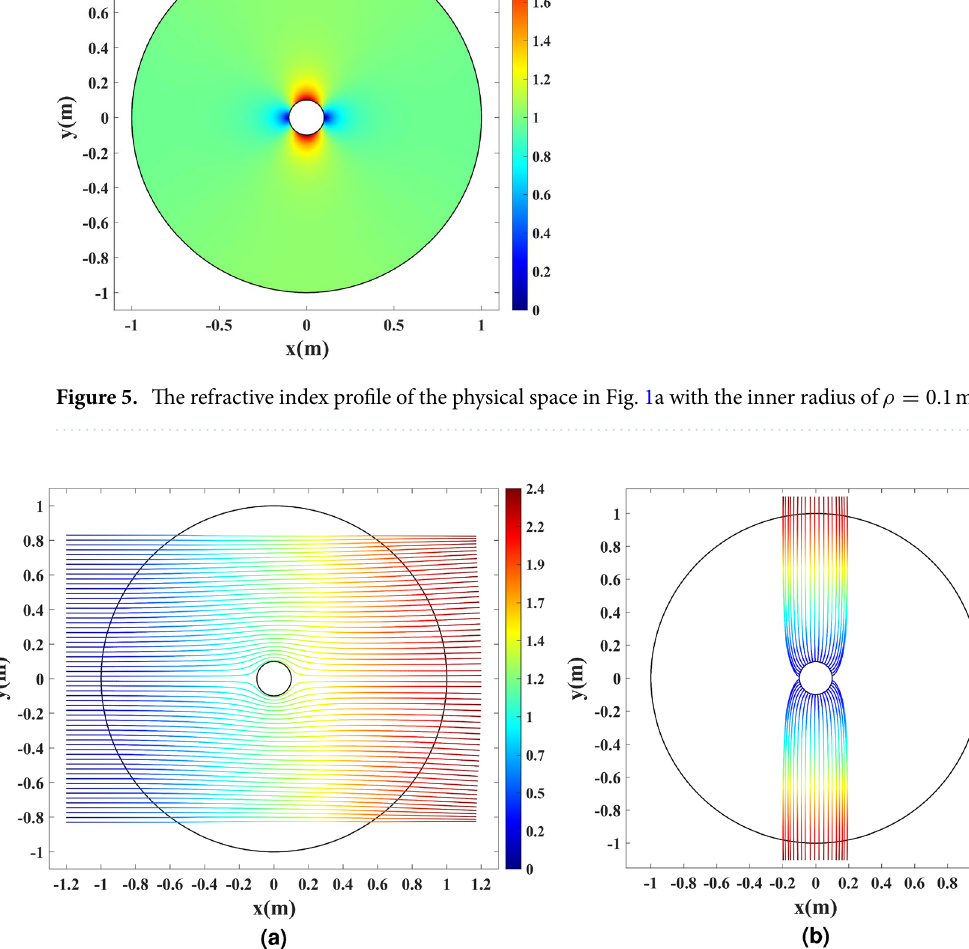
Figure 6. Ray-tracing simulation of the physical space with the refractive index depicted in Fig. 5. ( a ) The cloaking effect for 60 parallel rays launched along the x -axis. ( b ) The directivity enhancement effect for 38 equally-spaced rays launched from the inner rim. The color expression presents the optical path length in